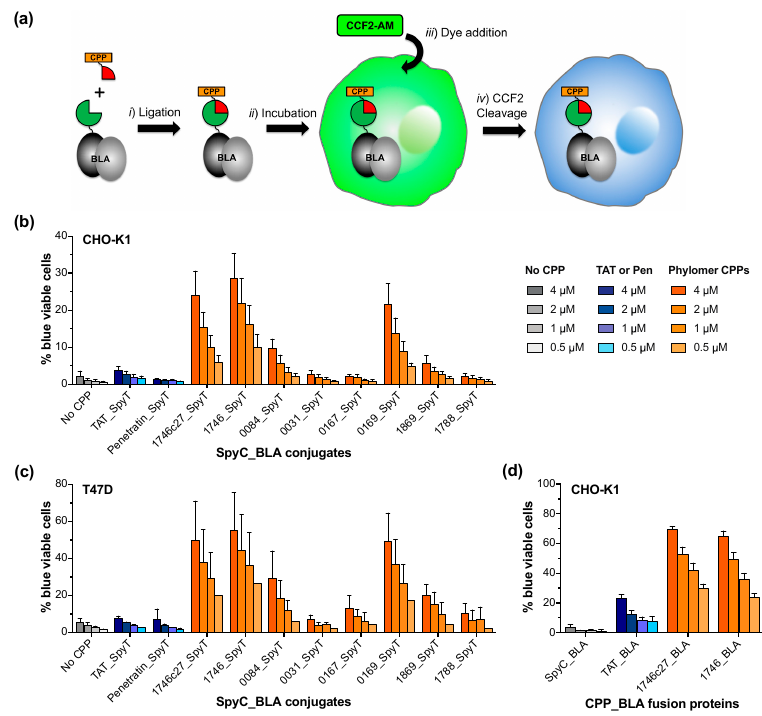
Figure 1. A cell penetrating peptide (CPP)- mediated β -lactamase internalization assay. ( a ) Recombinant β -lactamase can be delivered into cells when conjugated to CPPs, for example through SpyTag/SpyCatcher conjugation chemistry (step i ). The internalization of β -lactamase (step ii ) is detected after the addition of dye substrate (step iii ) through cleavage of cytosol-retained CCF2 substrate (step iv ), which is measured via a change in fluorescence signal from green (520 nm) to blue (450 nm); ( b ) The internalization of CPP-conjugated SpyC_ β -lactamase (SpyC_BLA) in CHO-K1 cells is dose-dependent, resulting in an increase in the percentage of blue viable cells as estimated by flow cytometry. Increased fluorescence is indicative of greater cytoplasmic delivery capacity of the CPP. β -Lactamase is conjugated to conventional CPPs TAT_SpyT ( n = 4) and Penetratin_SpyT ( n = 2), as well as phylomer CPPs 1746c27_SpyT ( n = 7), 1746_SpyT ( n = 5), 0084_SpyT ( n = 6), and 0031_SpyT, 0167_SpyT, 0169_SpyT, 1869_SpyT, and 1788_SpyT ( n = 3). Unconjugated SpyC_BLA does not internalize (‘No CPP’ negative control; n = 7). Error bars represent standard error of the mean of n independent experiments (duplicate samples within each experiment); ( c ) The internalization of CPP-conjugated SpyC_BLA in T47D cells is also dose-dependent, resulting in an increase in the percentage of blue viable cells as estimated by flow cytometry. β -Lactamase is conjugated to conventional CPPs TAT_SpyT and Penetratin_SpyT ( n = 1), as well as Phylomer CPPs 1746c27_SpyT, 1746_SpyT, 0084_SpyT, 0031_SpyT, 0167_SpyT, 0169_SpyT, 1869_SpyT, and 1788_SpyT ( n = 3). Unconjugated SpyC_BLA does not internalize (No CPP negative control; n = 3). Error bars represent standard error of the mean of n independent experiments (duplicate samples); ( d ) The internalization of recombinantly expressed CPP_ β -lactamase fusion protein (CPP_BLA) is dose-dependent, resulting in an increase in the percentage of blue viable cells as estimated by flow cytometry. β -Lactamase is expressed fused to conventional CPP TAT ( n = 3), as well as Phylomer CPPs 1746c27 and 1746 ( n = 2). SpyC_BLA (negative control) does not internalize. Error bars represent standard error of the mean of n independent experiments (CPP samples in triplicate; SpyC_BLA samples in triplicate ( n = 1) and duplicate ( n = 2)).